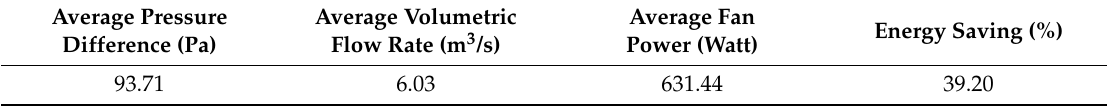
Table 4. Energy saving for case 7 in 1800 s.